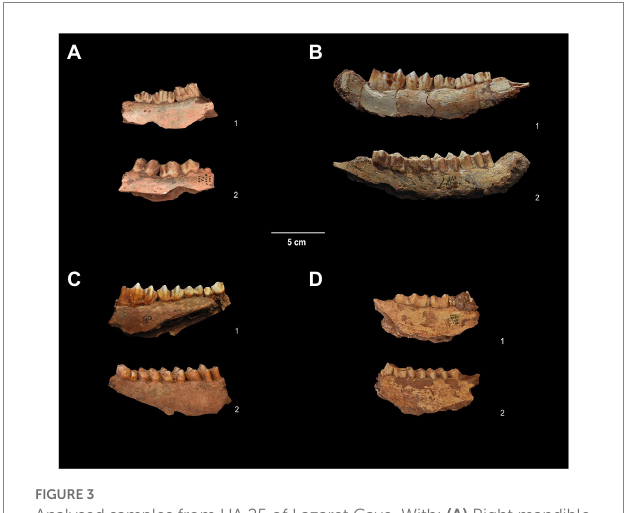
FIGURE 3 Analysed samples from UA 25 of Lazaret Cave. With: (A) Right mandible of Cer vus elaphus with p/3-m/1 (T9 BT29T n ° 60, UA25), 1 = lingual view, 2 = buccal view; (B) Left mandible of Cervus elaphus with p/3-m/3 (S17 JE71T n ° 1873, UA25), 1 = lingual view, 2 = buccal view; (C) Left mandible of Cervus elaphus with p/4-m/3 (Q14 GA88T n ° 3,731, UA25), 1 = lingual view, 2 = buccal view; (D) Left mandible of Capra ibex with p/3-m/3 (U9 BU9T n ° 85, UA25), 1 = lingual view, 2 = buccal view.